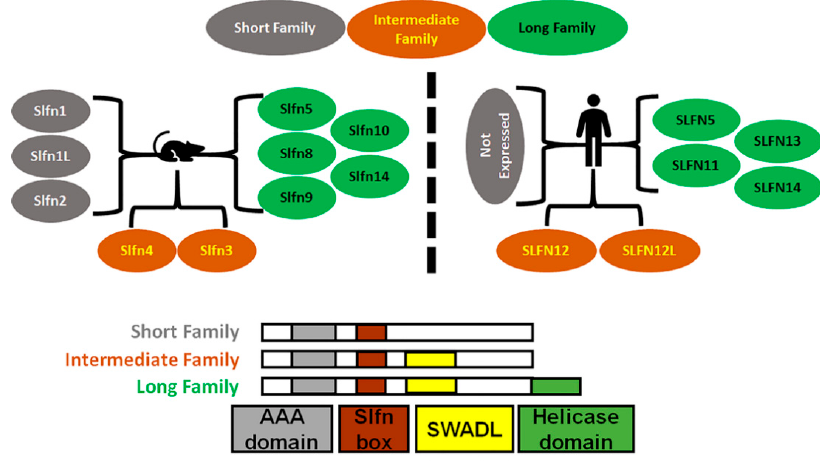
Figure 1. Diagrammatic representation of Schlafens family in mice and humans. Schlafens are classified into three families: short (grey), intermediate (orange), and long (green). Humans do not express short family Schlafens. All Schlafens share the SLFN box and putative AAA domains, while the SWADL domain is found in only intermediate and long Schlafens. Long Schlafens have an extra C-terminal helicase domain that harbors a nuclear targeting sequence. SLFN5/Slfn5 and SLFN14/Slfn14 are the only direct orthologs between humans and mice. However, Slfn3 and Slfn4 share significant homology with SLFN12 and SLFN12L and have therefore also been identified as their orthologs [7]. Phylogenic analysis suggests Slfn8, Slfn9, and Slfn10 are orthologs to SLFN13 , but there is no evidence or functional study that confirms a mouse ortholog of SLFN11 .